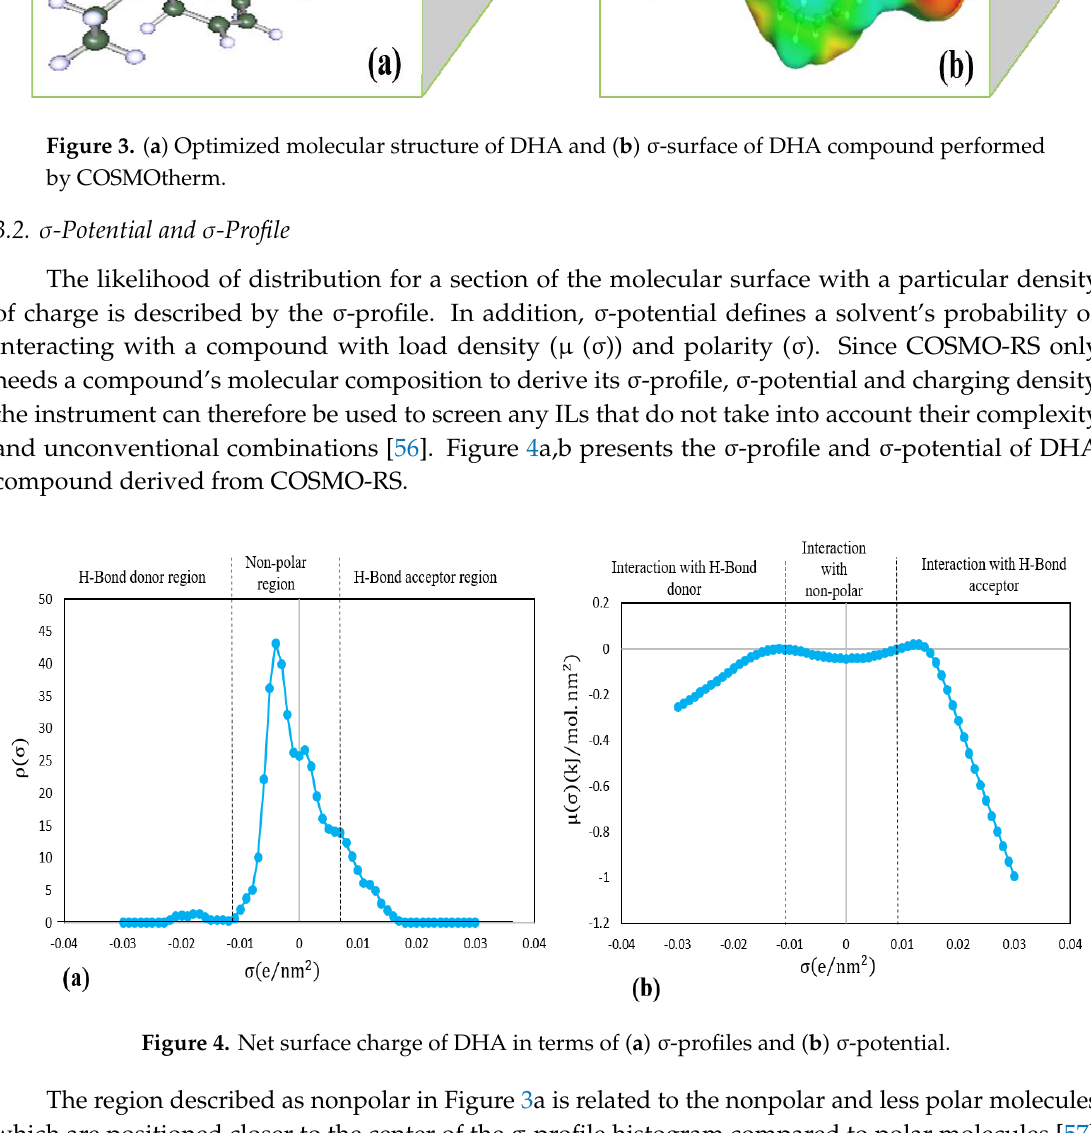
Figure 4. Net surface charge of DHA in terms of ( a ) σ -profiles and ( b ) σ -potential.